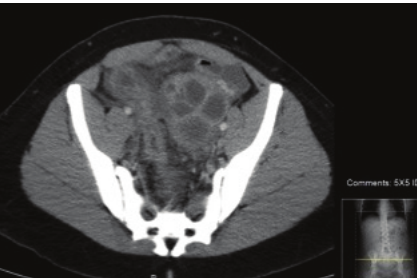
Figure 1: CT scan showing a large multicystic left ovarian mass measuring 6 × 9cm.